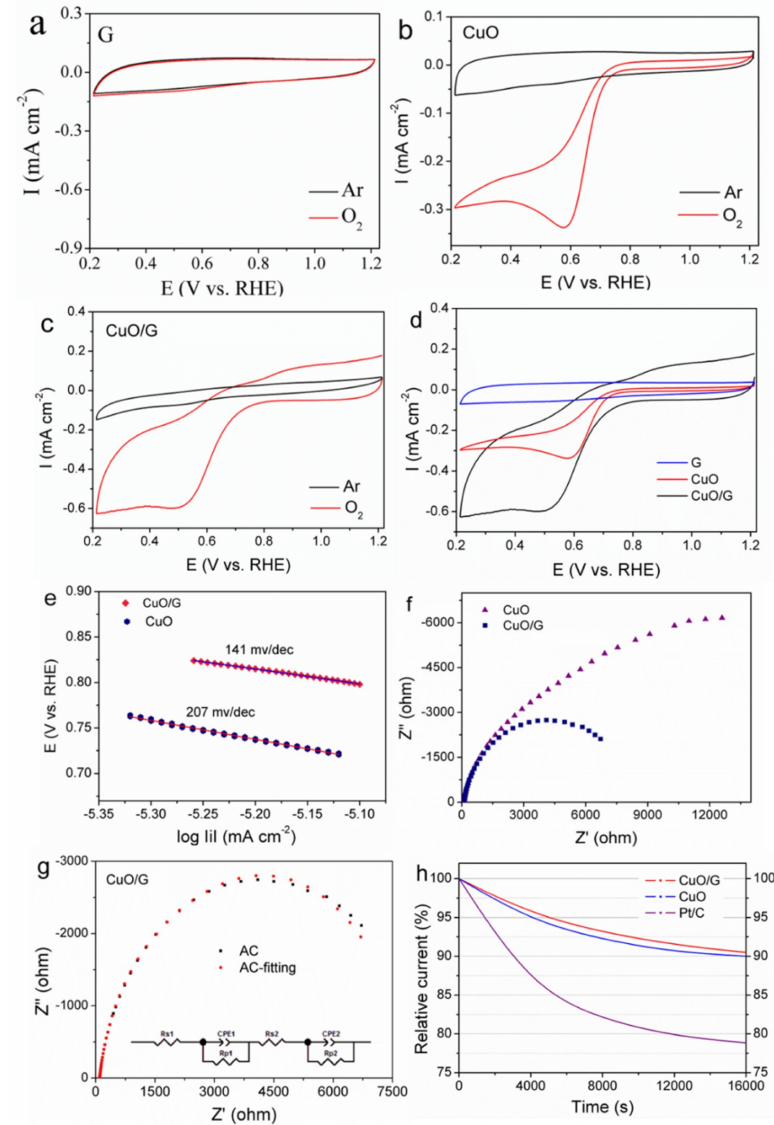
Figure 3. CVs of ( a ) G, ( b ) CuO and ( c ) CuO/G in Ar and O 2 -saturated 0.1 mol/L KOH at 25 ◦ C. ( d ) Comparation of CV tests of G, CuO and CuO/G in O 2 -saturated 0.1 M KOH. Scan rate: 5 mV/s. ( e ) Tafel plots and ( f ) comparison of nyquist plots during ORR on CuO and CuO/G. ( g ) Modulated equivalent circuit of nyquist plot on CuO/G. ( h ) Chronoamperometry of CuO, CuO/G and commercial Pt/C catalyst at − 0.65 V for 16,000